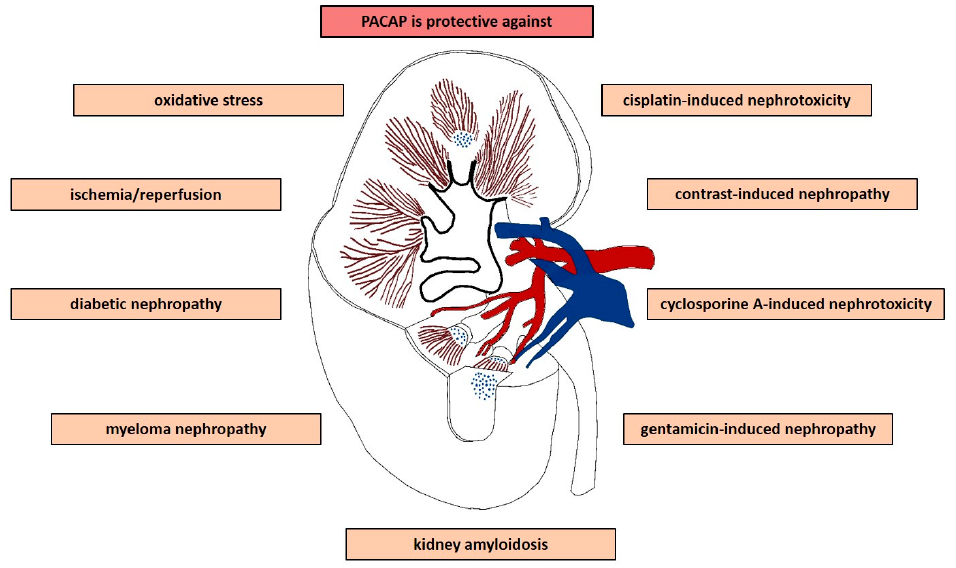
Figure 1. Summary of renoprotective e ff ects of PACAP. List of renal pathologic conditions, in which protective e ff ect of PACAP was evaluated. Table 1. Summary of the renoprotective effects of PACAP against different stressors. ( ↑ increasing effect, ↓ decreasing effect).